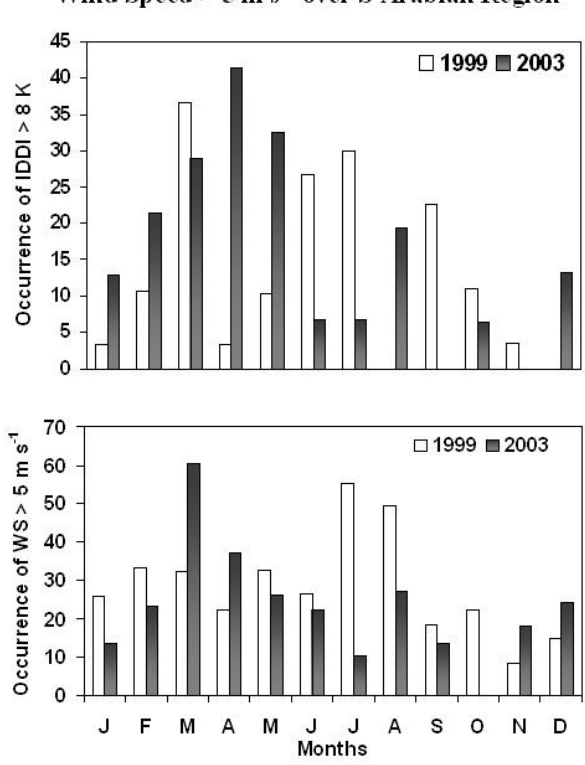
Fig. 1. The percentage of occurrence with IDDI > 8 K and wind speed U> 5 m s -1 over Saudi Arabia.